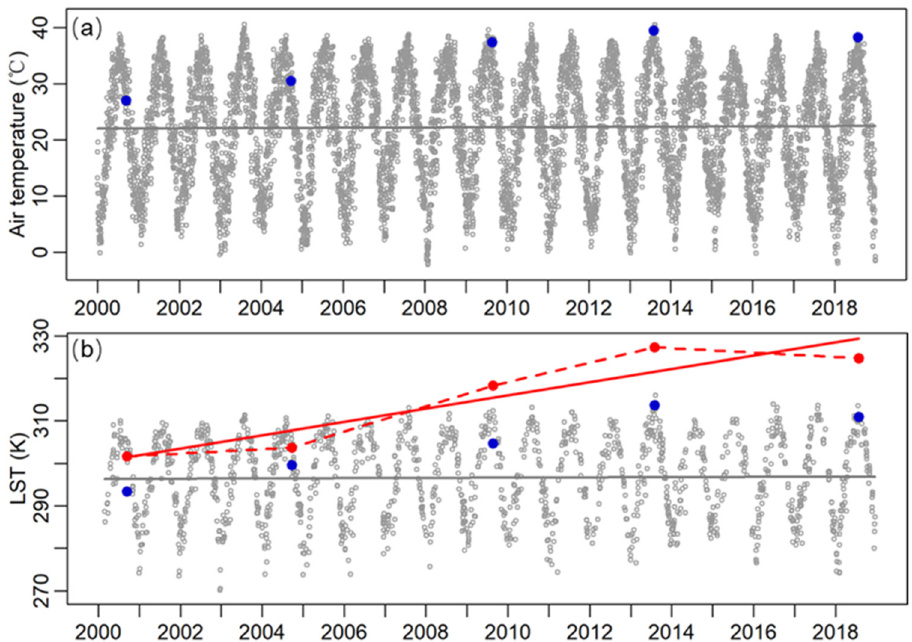
Figure 1. Time series of daily maximum air temperature ( a ) and MODIS Terra daytime LST ( b ) for a weather station in Changsha, China, from 2000 to 2020. The grey lines are the fitted linear regression lines; the blue points are air temperature and MODIS LST for the days when Landsat LSTs are available; the red points are Landsat LST of the selected days.